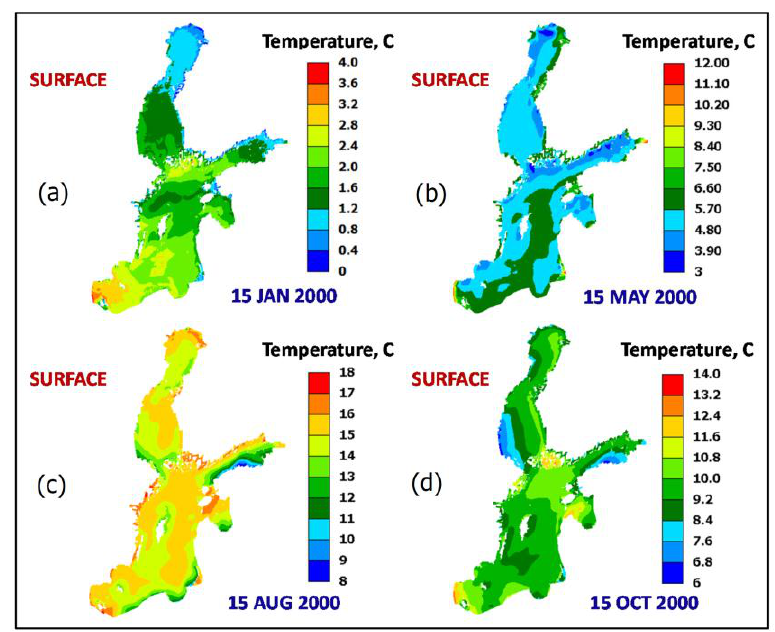
Figure 11. Seasonal surface temperature contour plots for the year 2000. ( a ) Winter; ( b ) Spring; ( c ) Summer; ( d ) Autumn.